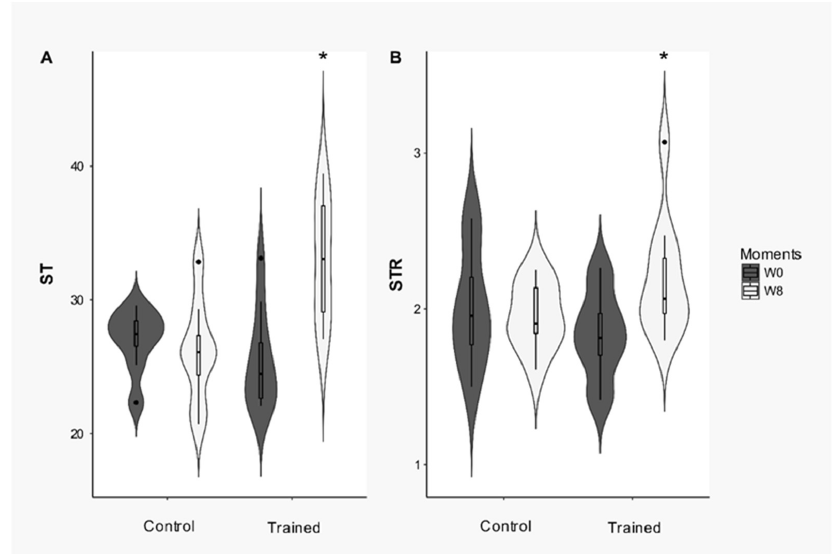
Figure 5. Changes in myocardial deformation ( A ) Strain and ( B ) strain rate of the left ventricle in dogs after 8 weeks of physical training. *: Difference from week zero (W0); ( p < 0.05). PCA characterizes and compiles a dataset to mitigate the dimensionality of the nine- teen measured echocardiographic variables into three components (58.35% of the total